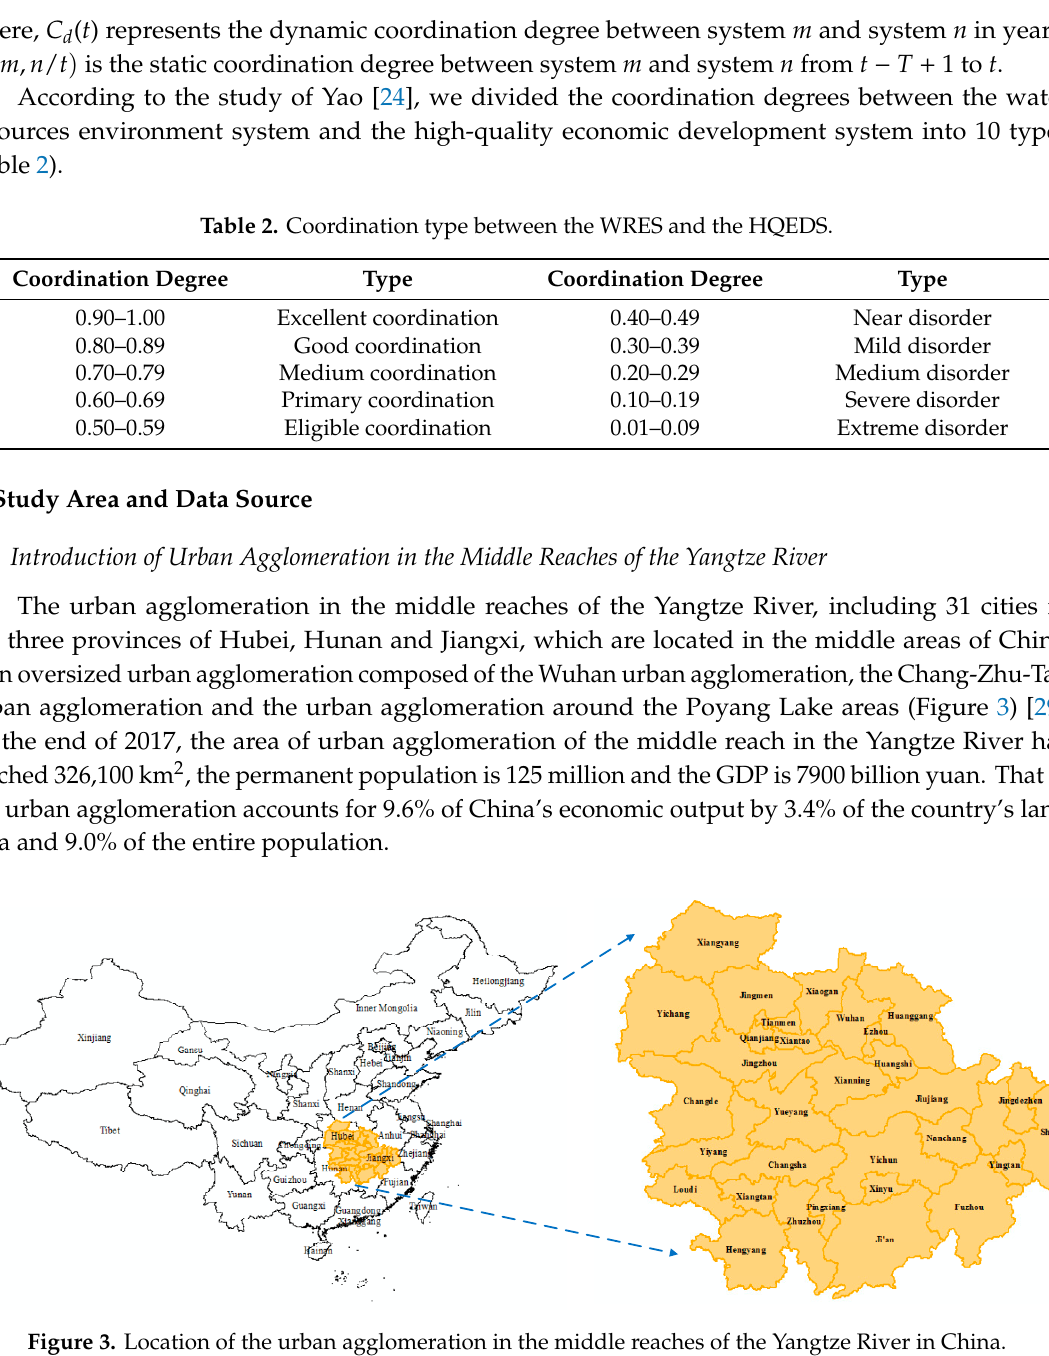
Figure 3. Location of the urban agglomeration in the middle reaches of the Yangtze River in China.